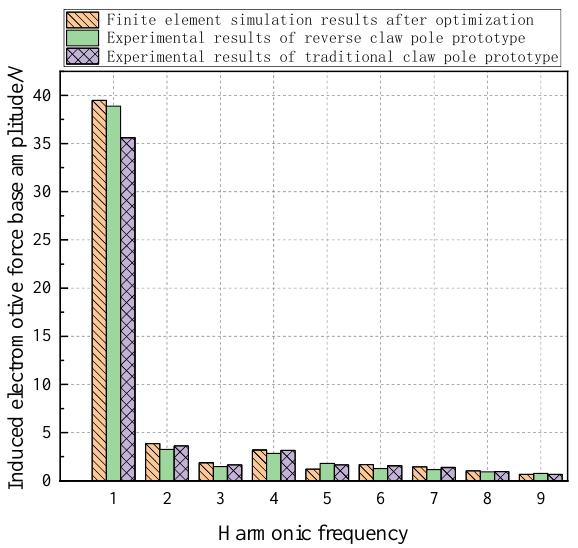
Figure 16. No-load induced electromotive force curve change.